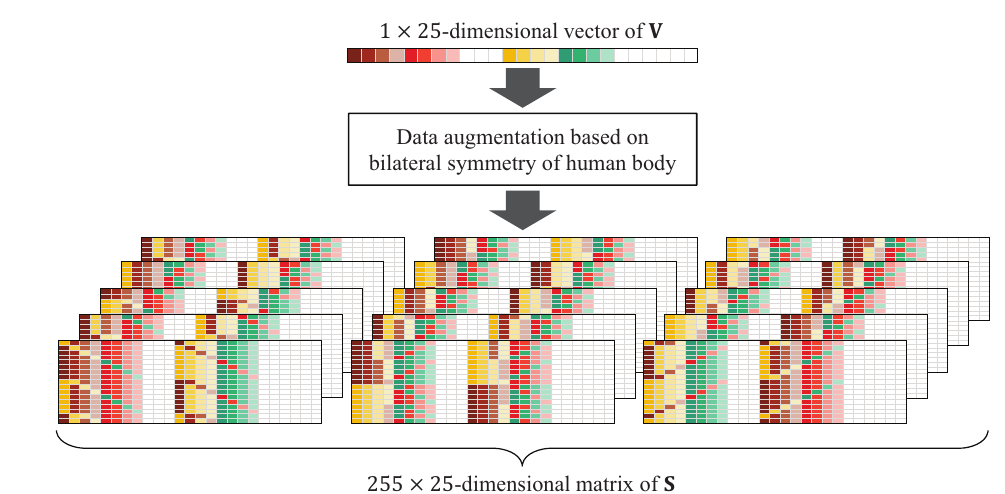
Figure 9. Anthropometric feature vectors (255 samples).